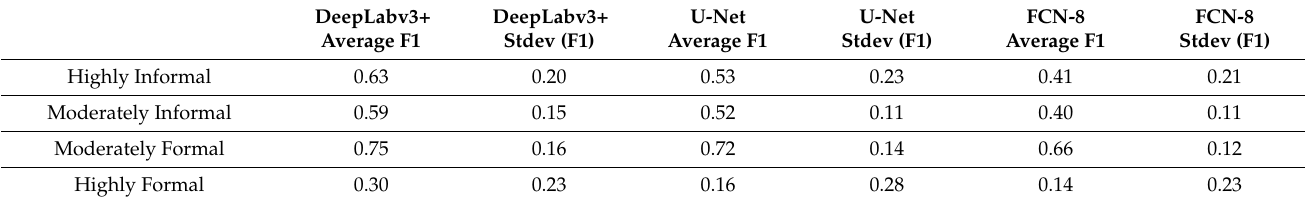
Table 3. Performance summary for DeepLabv3+, U-Net, and